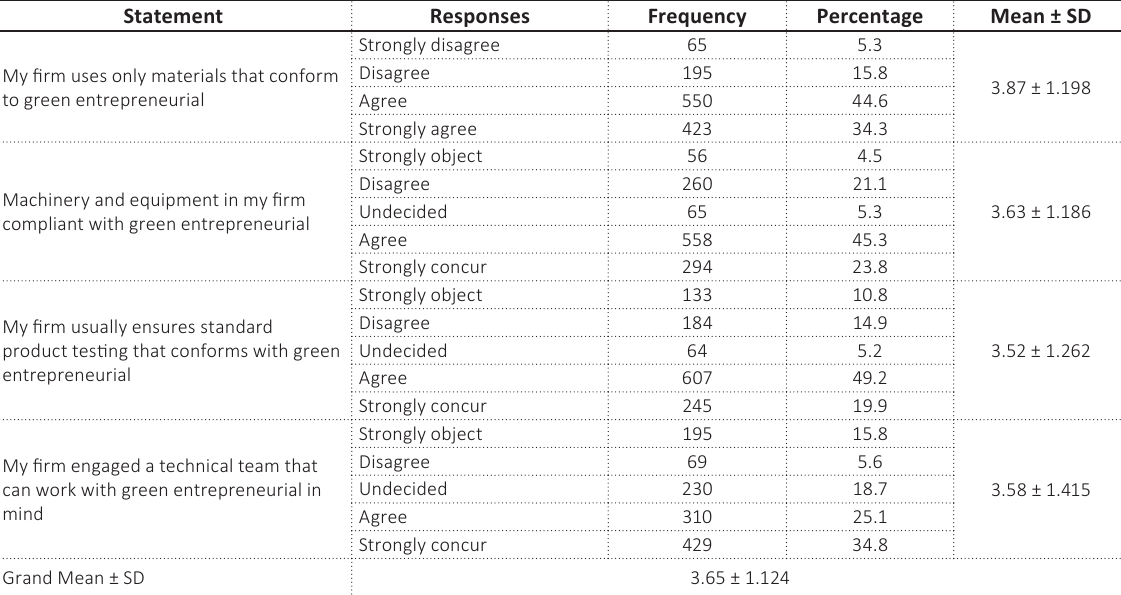
Source: Authors’ elaboration.